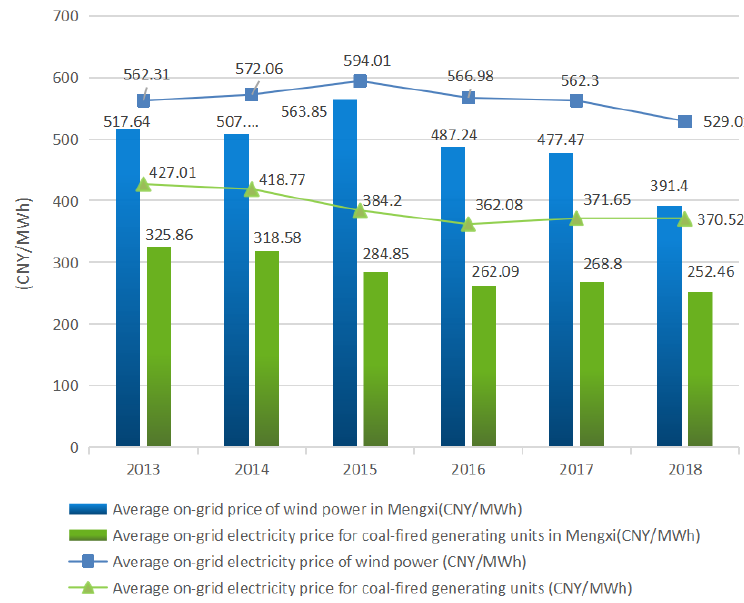
Figure 9. China’s on -grid electricity prices for wind power and coal-fired power.